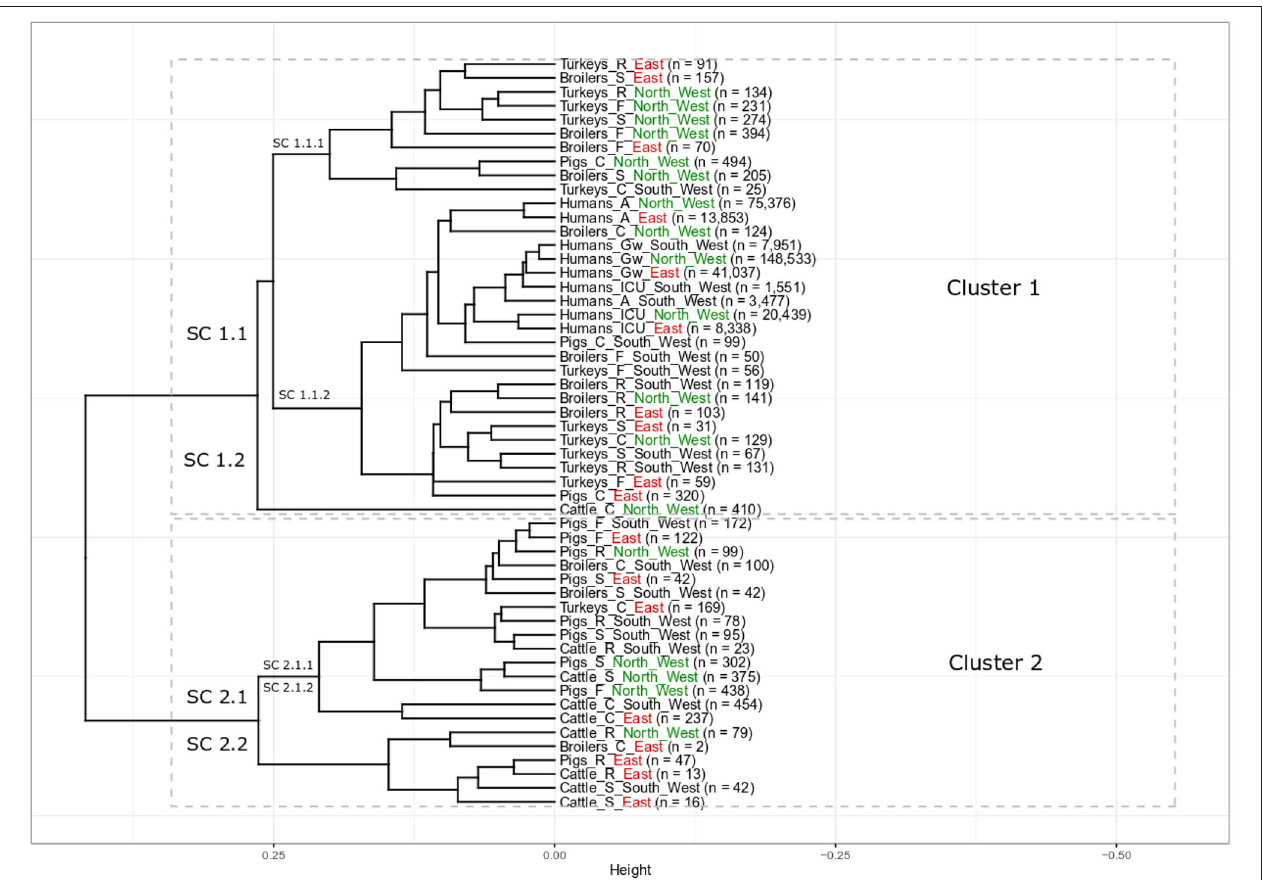
FIGURE 1 | Results of cluster analysis of the resistance combinations in E. coli isolates from 18 grouped populations from different human and food-producing animal populations between 2014 and 2017. There are two main clusters with eight sub-clusters (SC). Human population: A: isolates from outpatient care, Gw: isolates from general ward and ICU: isolates from intensive care unit. Animal population: F: isolates from farms, S: isolates from slaughterhouse and R: isolates from retail, C: clinical isolates from animals. n is the total number of included isolates. For better regional separation, the regions are additionally color coded with North West in green, East in red and South West in